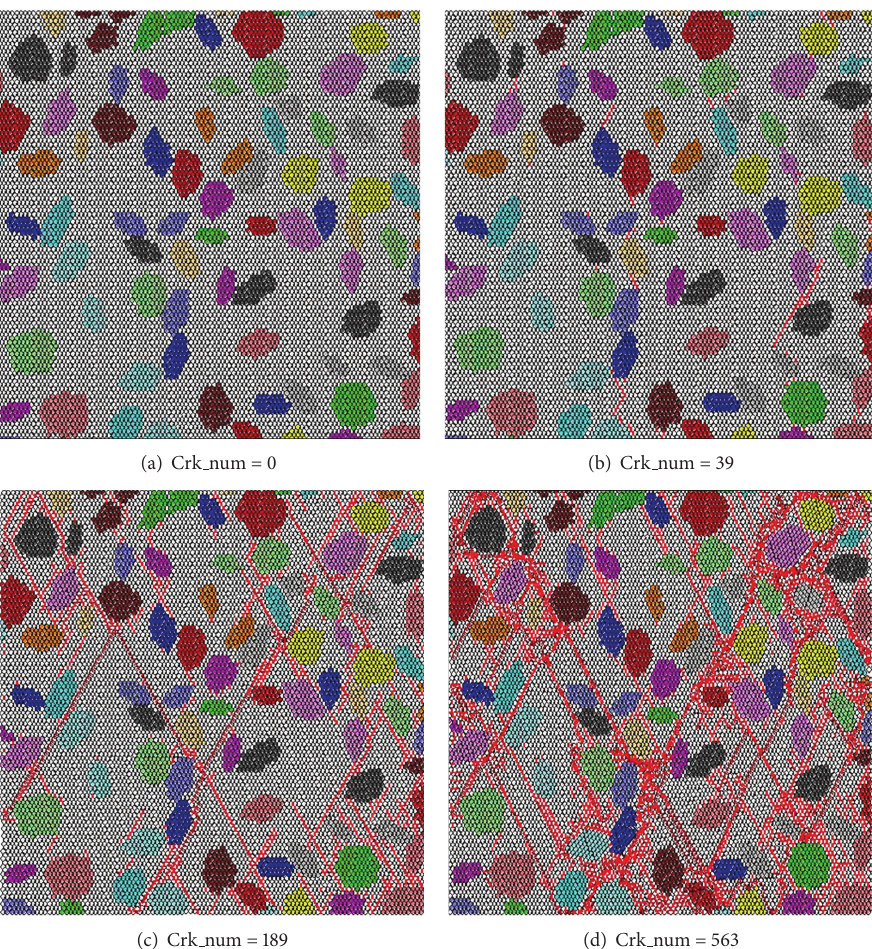
Figure 13: The damage of outwash deposits with different stone block content; (a) shows a model with the initial content rate of stone block 40%; (b) shows the cracks which first appear between some blocks; (c) shows fracture development among the boundary of stone blocks; and (d) shows the damaged outwash